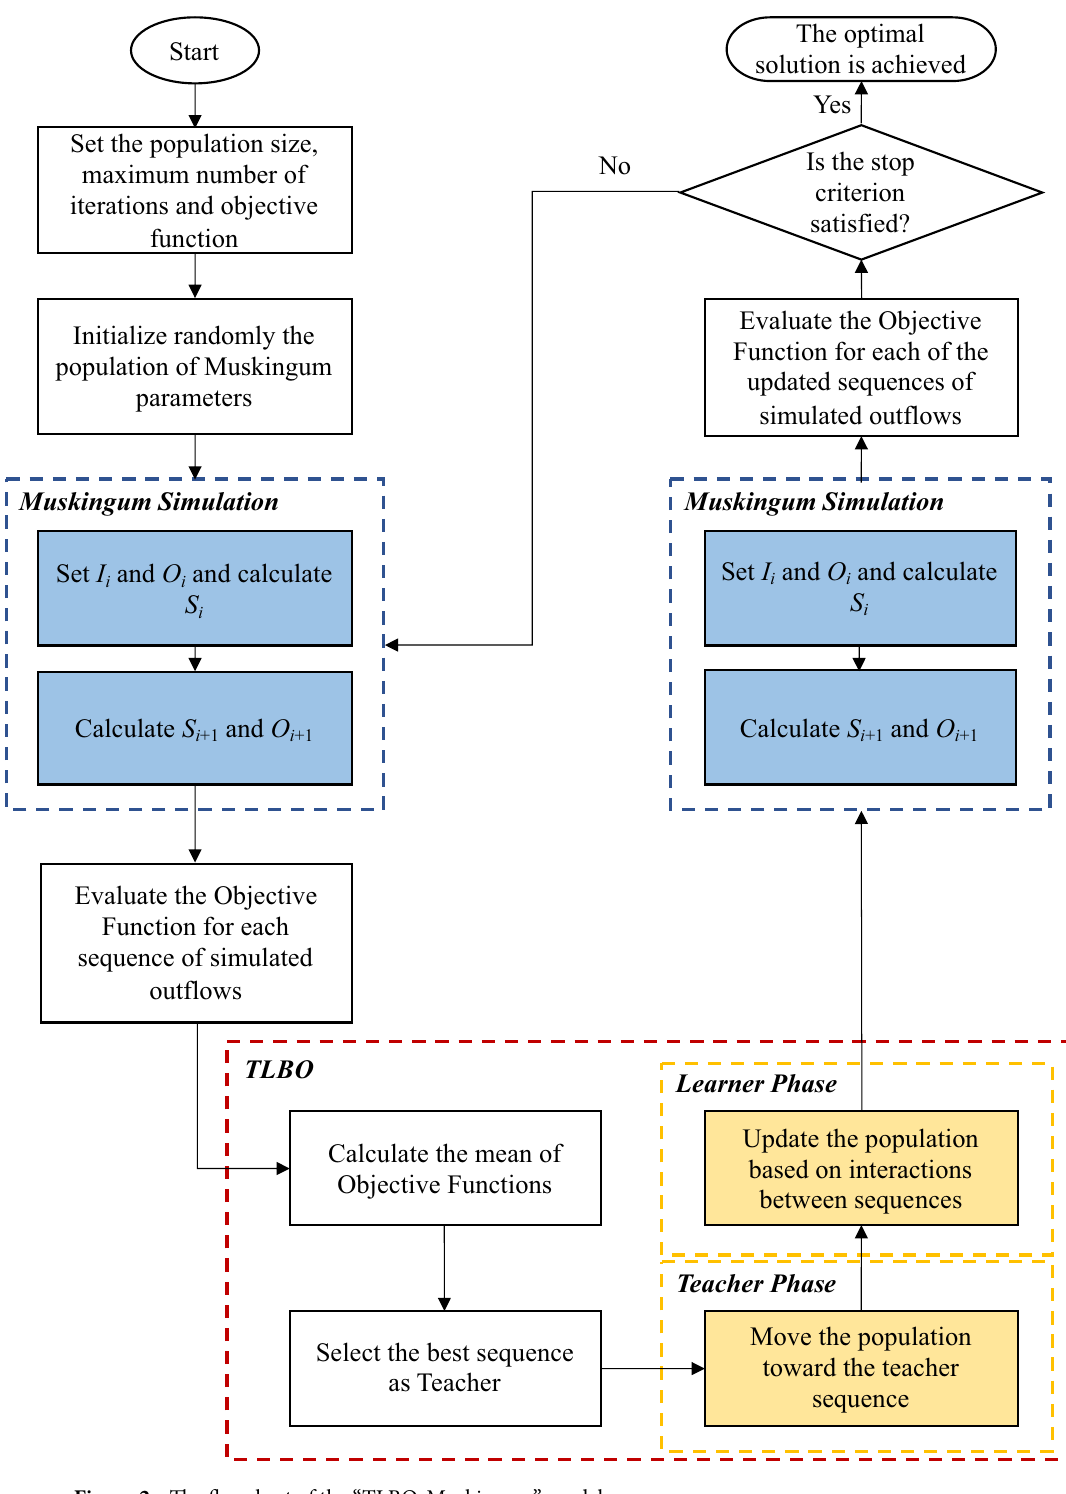
Figure 2. The flowchart of the “TLBO-Muskingum”